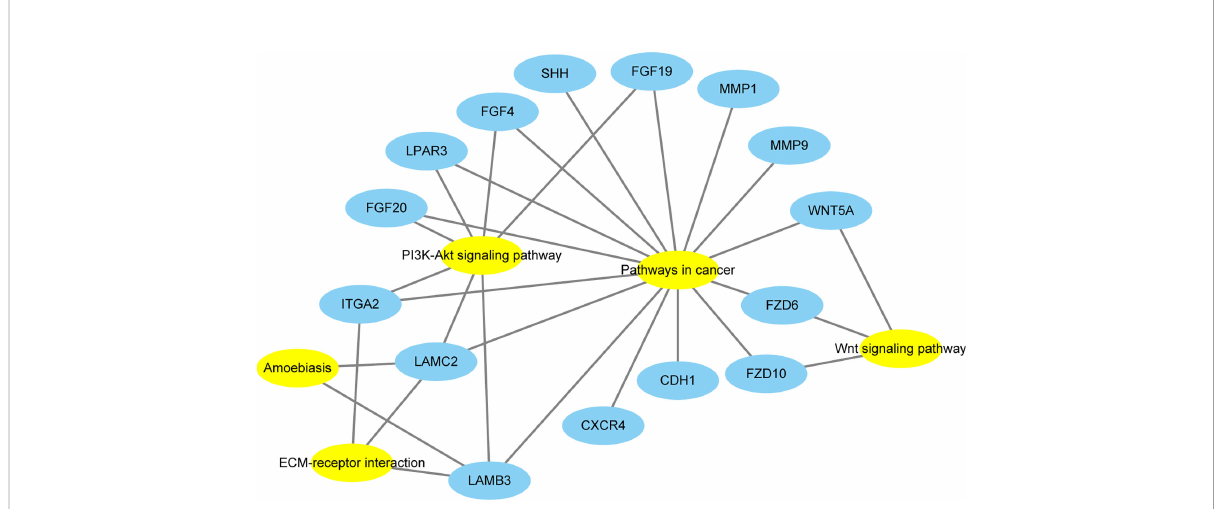
FIGURE 5 The relationship between this unique pathway (Pathway in cancer) and related pathways and genes. Yellow represents the pathways, and blue represents the